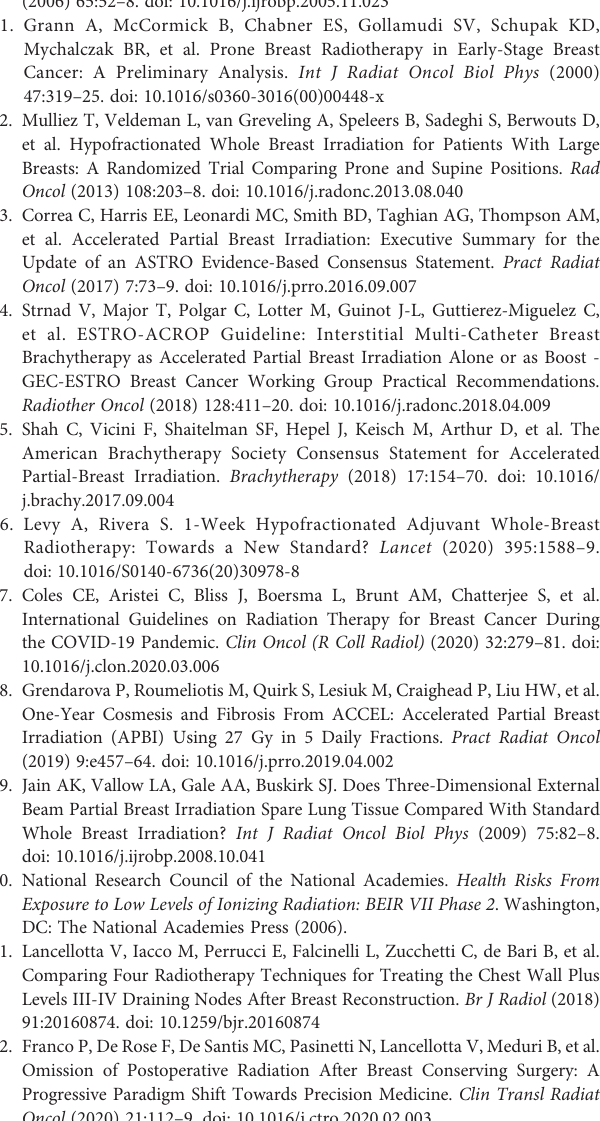
Table 15.20 Cancer of the Lung and Bronchus (Invasive) (2018). Available at: